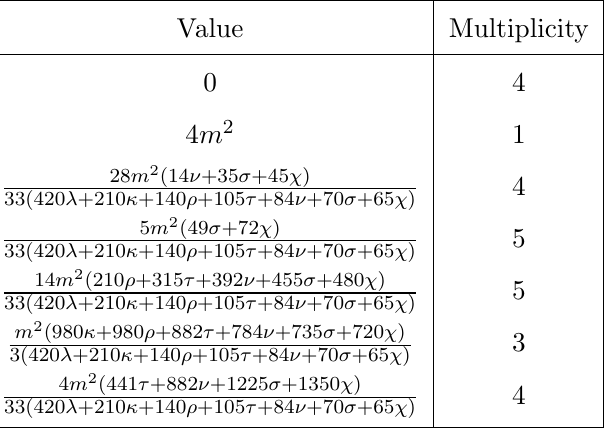
Table 7 . Scalar mass eigenstates for the SSB pattern SU(2) ! I 0 using a complex 13 of